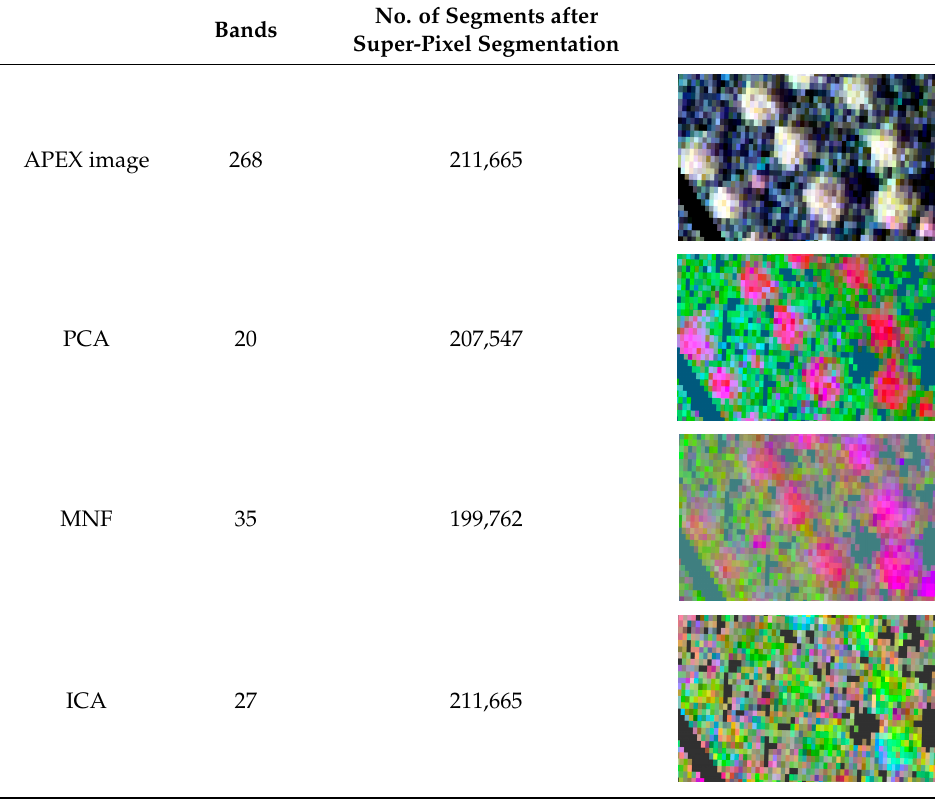
Table 1. The number of reduced bands after applying dimensionality reduction techniques. An example of a false color composite of the first three components for each dimensionality reduction technique are presented.